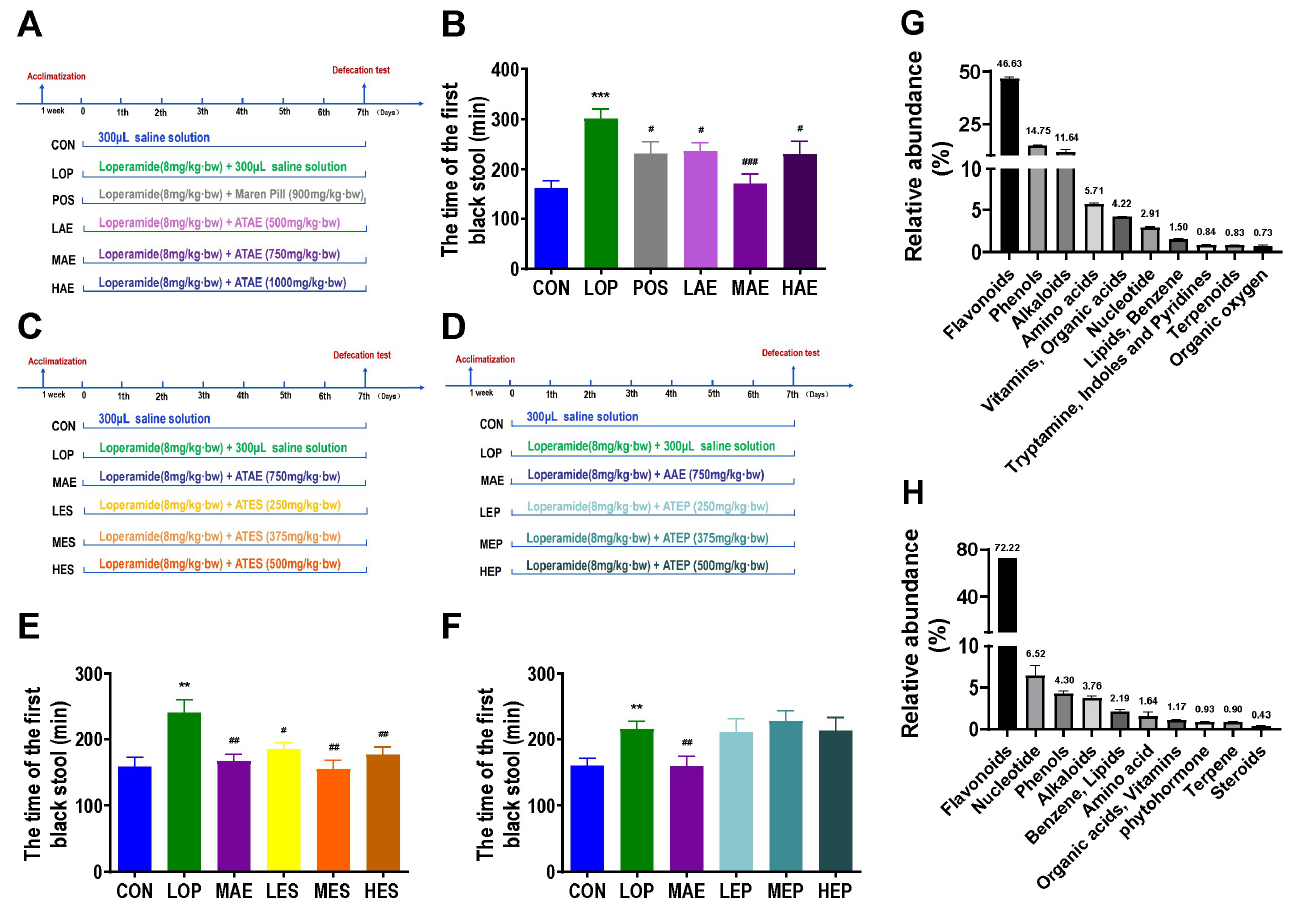
Figure 1. The laxative active fraction of ATAE and its main chemical composition. Grouping and basic workflow for animal experiments 1 ( A ), 2 ( C ) and 3 ( D ). The defecation time of the first black stool (FBST) in animal experiments 1 ( B ), 2 ( E ), and 3 ( F ). Chemical composition of ATES ( G ) and ATTF ( H ) based on widely targeted metabolomics. The data are expressed as the means ± SEMs ( n = 10–12). **, ***, compared with the CON group; #, ##, ###, compared with the LOP group. **, p < 0.01; ***, p < 0.001. #, p < 0.05; ##, p < 0.01; ###, p < 0.001.